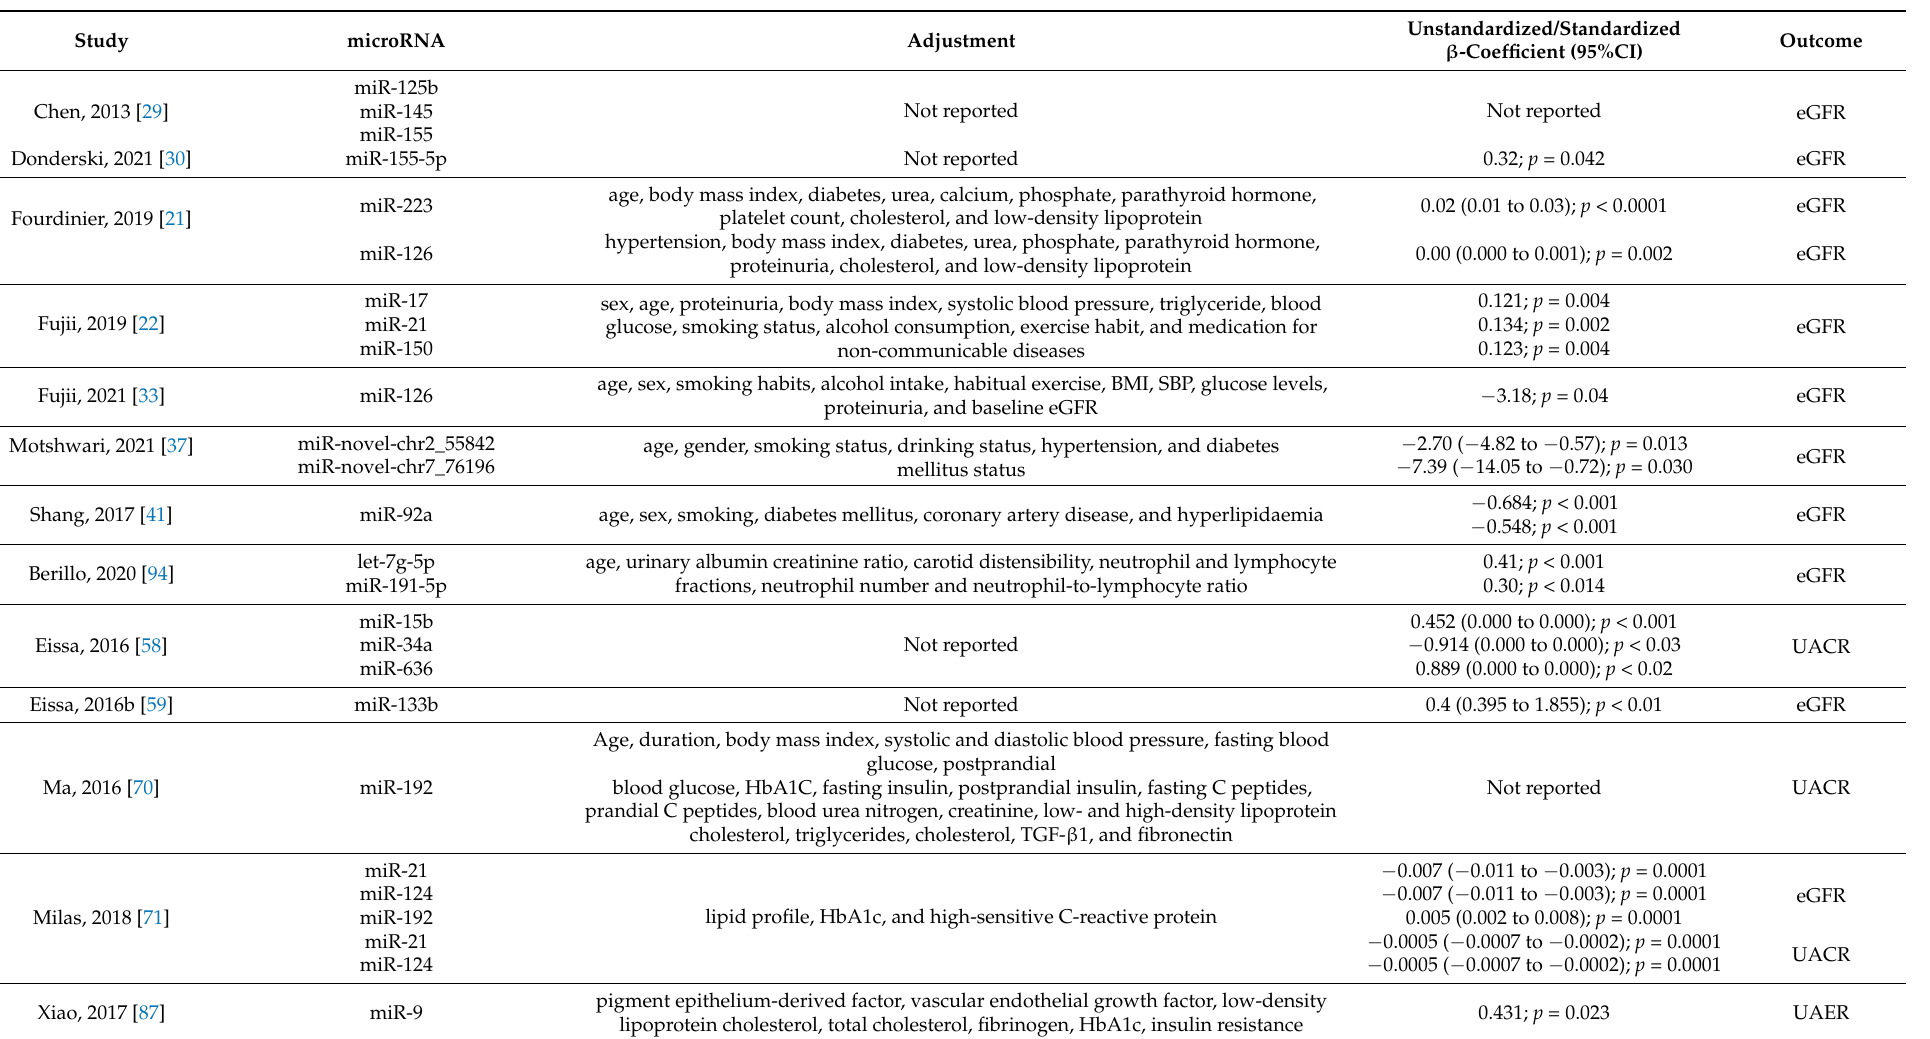
Table 6. Association of miRNAs with kidney function and